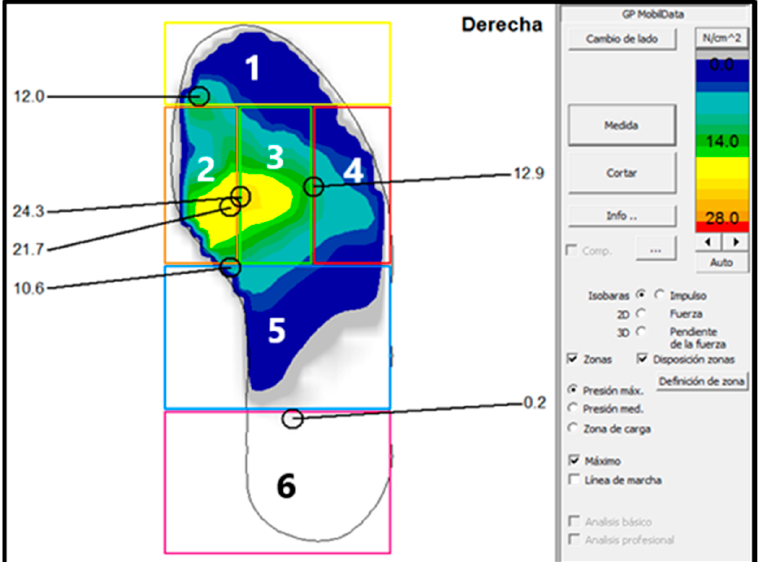
Figure 2. Presentation of the detailed overall system setup and an example of the acquired and processed data of the pressure measurement zones (D) for the toes (1), the first metatarsal (2), the second, third and fourth metatarsals (3), the head of the fifth metatarsal (4), the longitudinal arch of the foot (5), and the calcaneus (6).